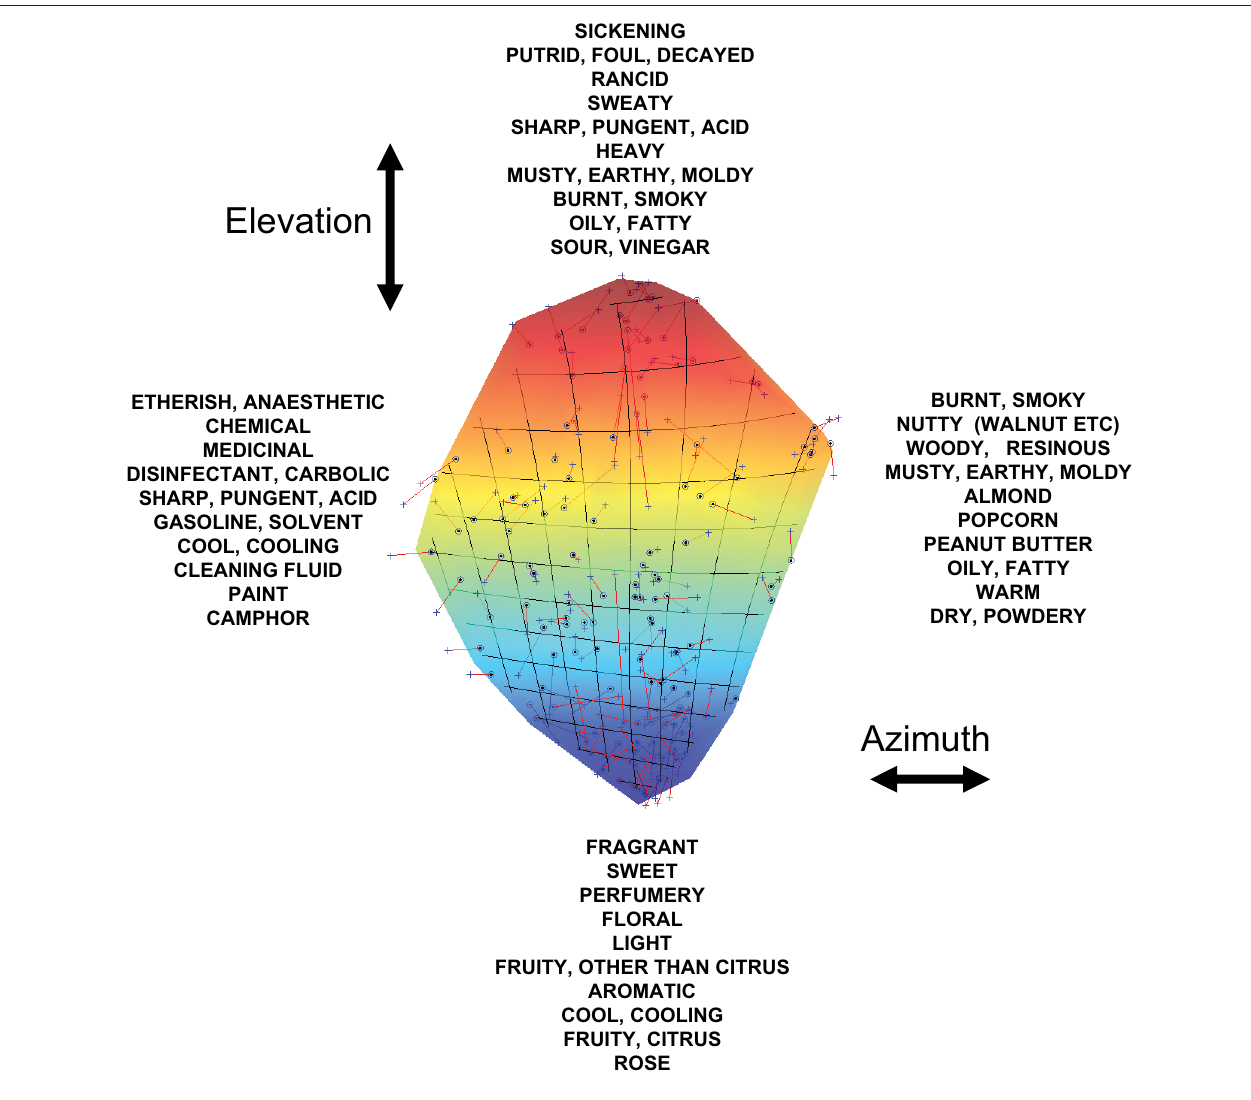
Figure 3 | The descriptors that contribute with large positive/negative coefficients to the coordinates on the 2D surface. The two coordinates are defined as elevation and azimuth